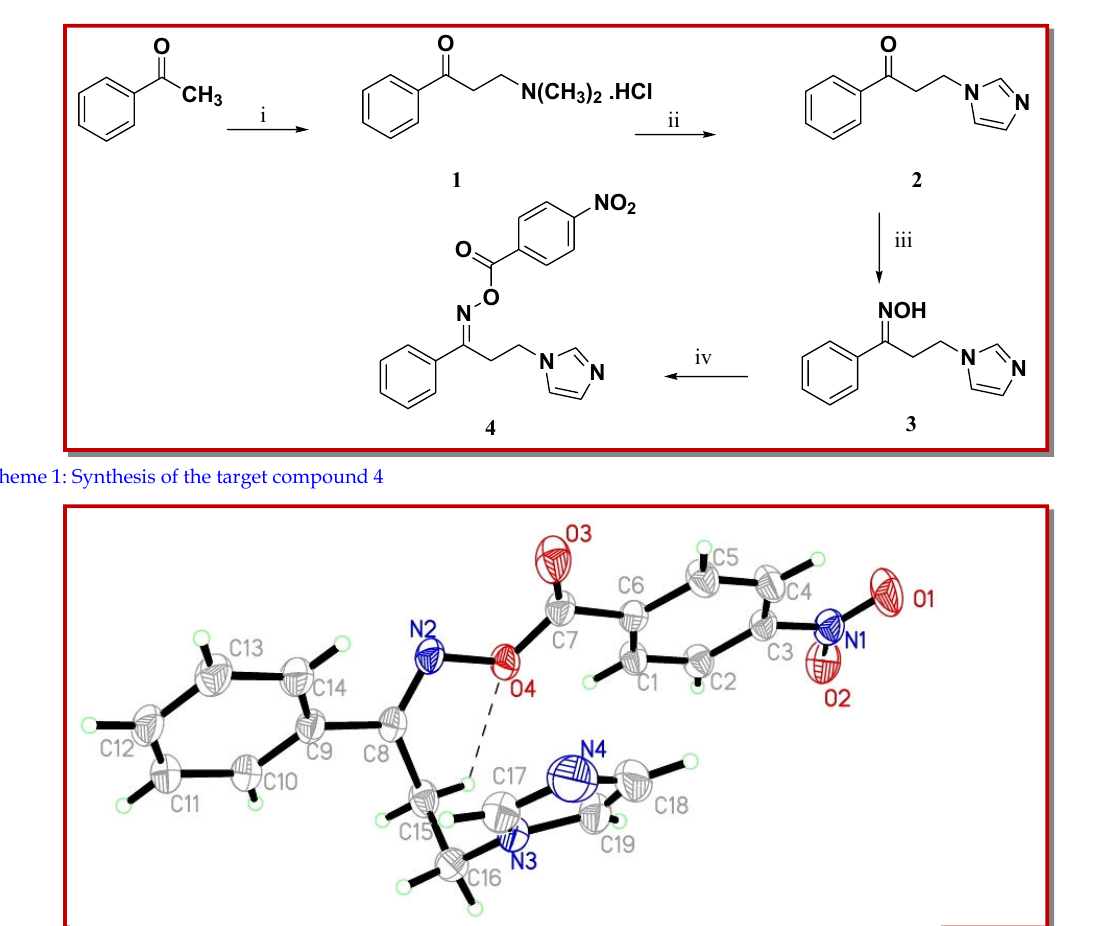
Figure 1: ORTEP diagram of the title compound 4 drawn at 50% ellipsoids for non-hydrogen atoms